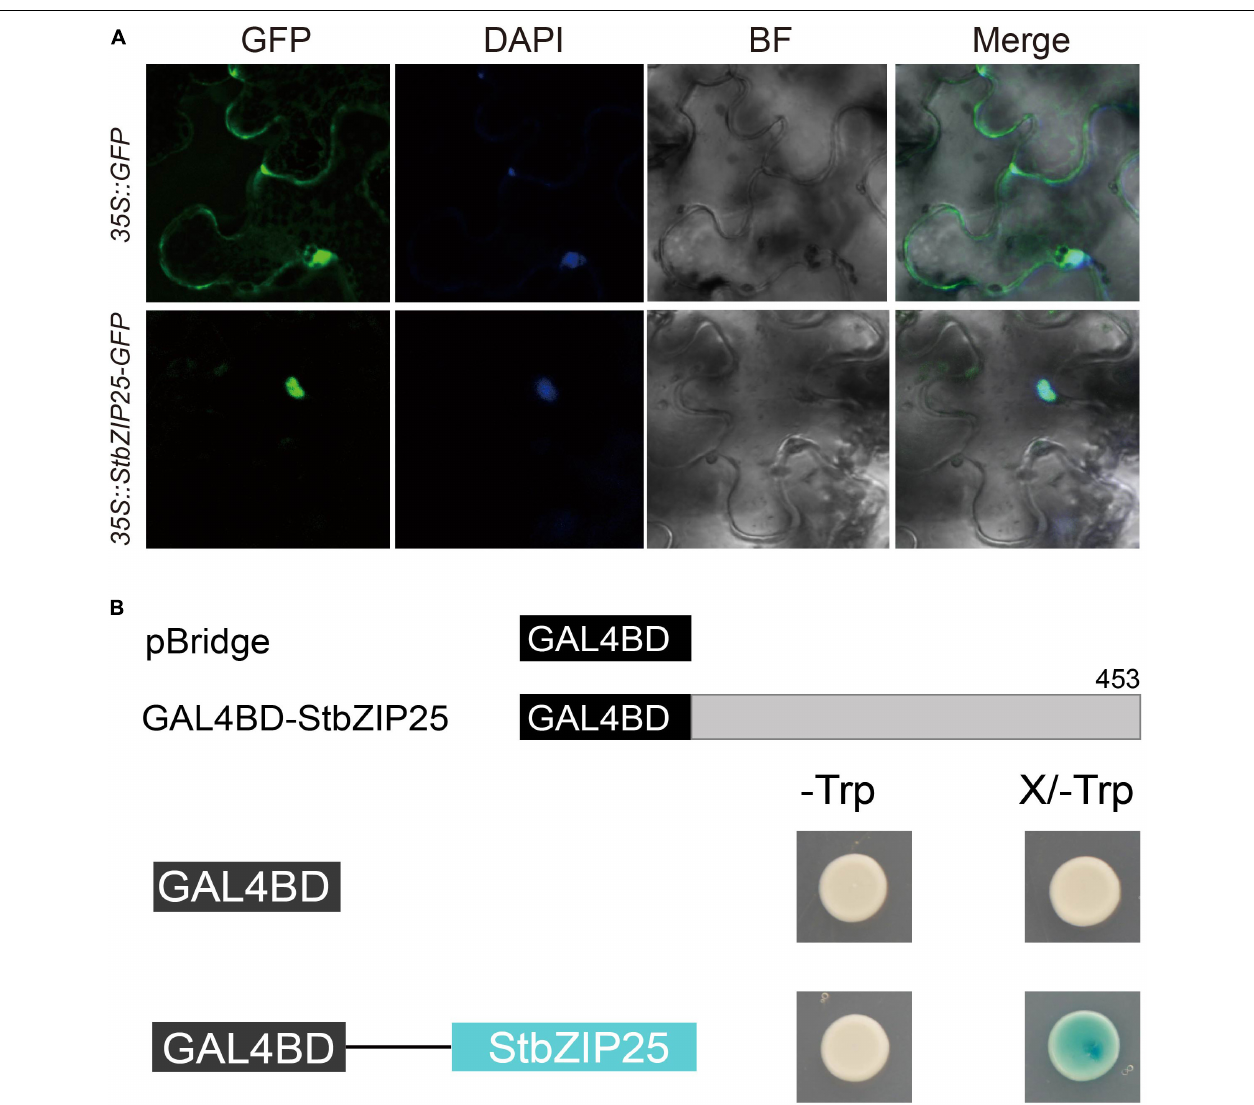
FIGURE 9 | The subcellular localization and transactivation assays of StbZIP25. (A) The StbZIP25-GFP fusion construct and the GFP gene driven by the CaMV-35S promoter were transiently expressed into tobacco. DAPI (dye 4,6-diamidino-2-phenylindole) staining indicated the nucleus. (B) Transactivation activity assay of StbZIP25 in yeast strain AH109. β -galactosidase activities against X-gal were detected on SD/-Trp